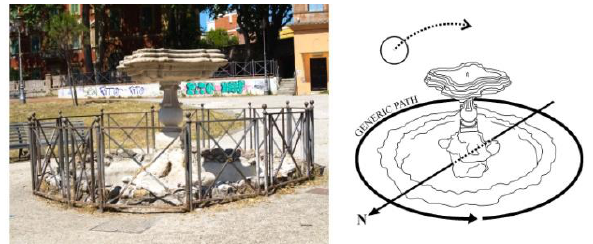
Figure 8. Left, the surveyed fountain in Villa Alberoni- Paganini; right, orientation of capture sequences.